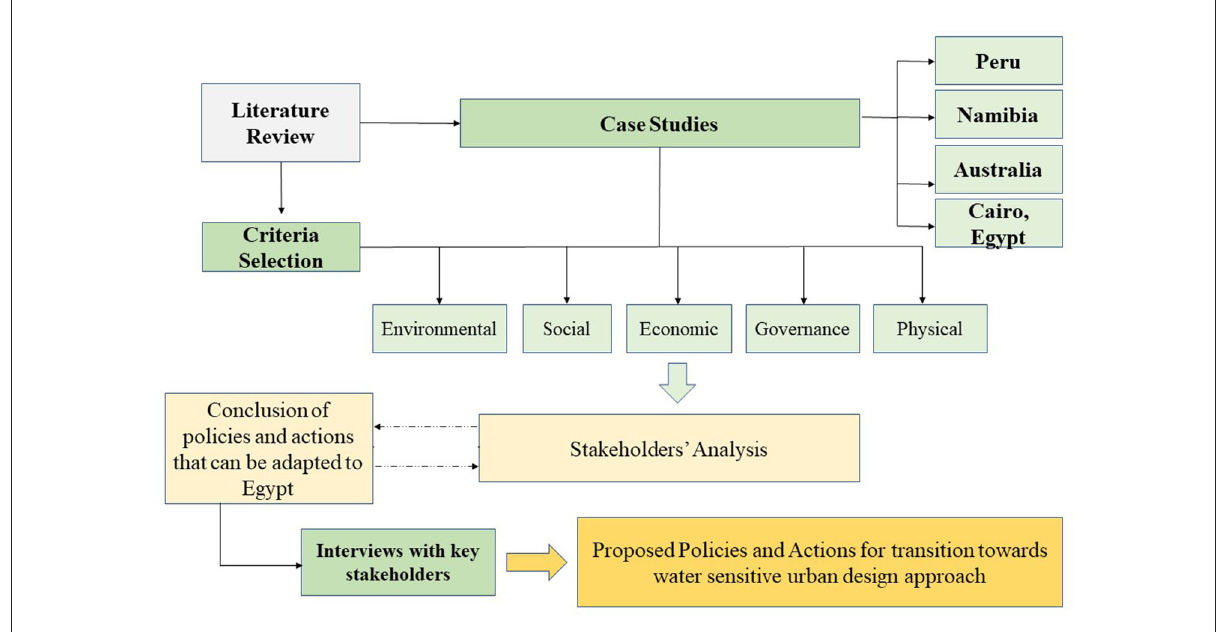
FIGURE1 Methodology used in the study starting by the literature review, till the proposed policies and actions.